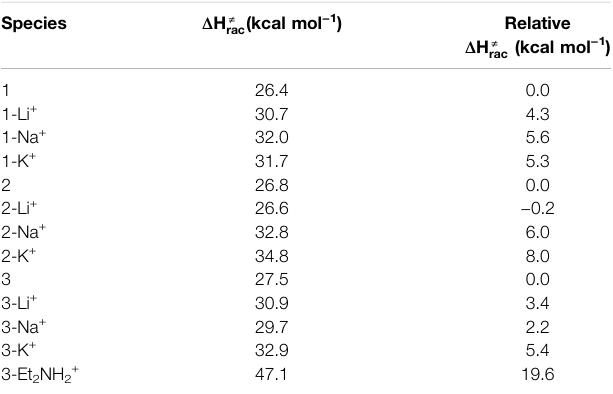
TABLE 2 | Calculated (PBE0-D3/Def2-TZVP) racemization enthalpies for the banisters 1 – 3 and their complexes. Species